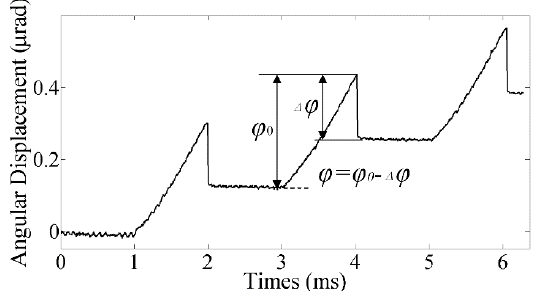
Figure 4. The backlash phenomenon.